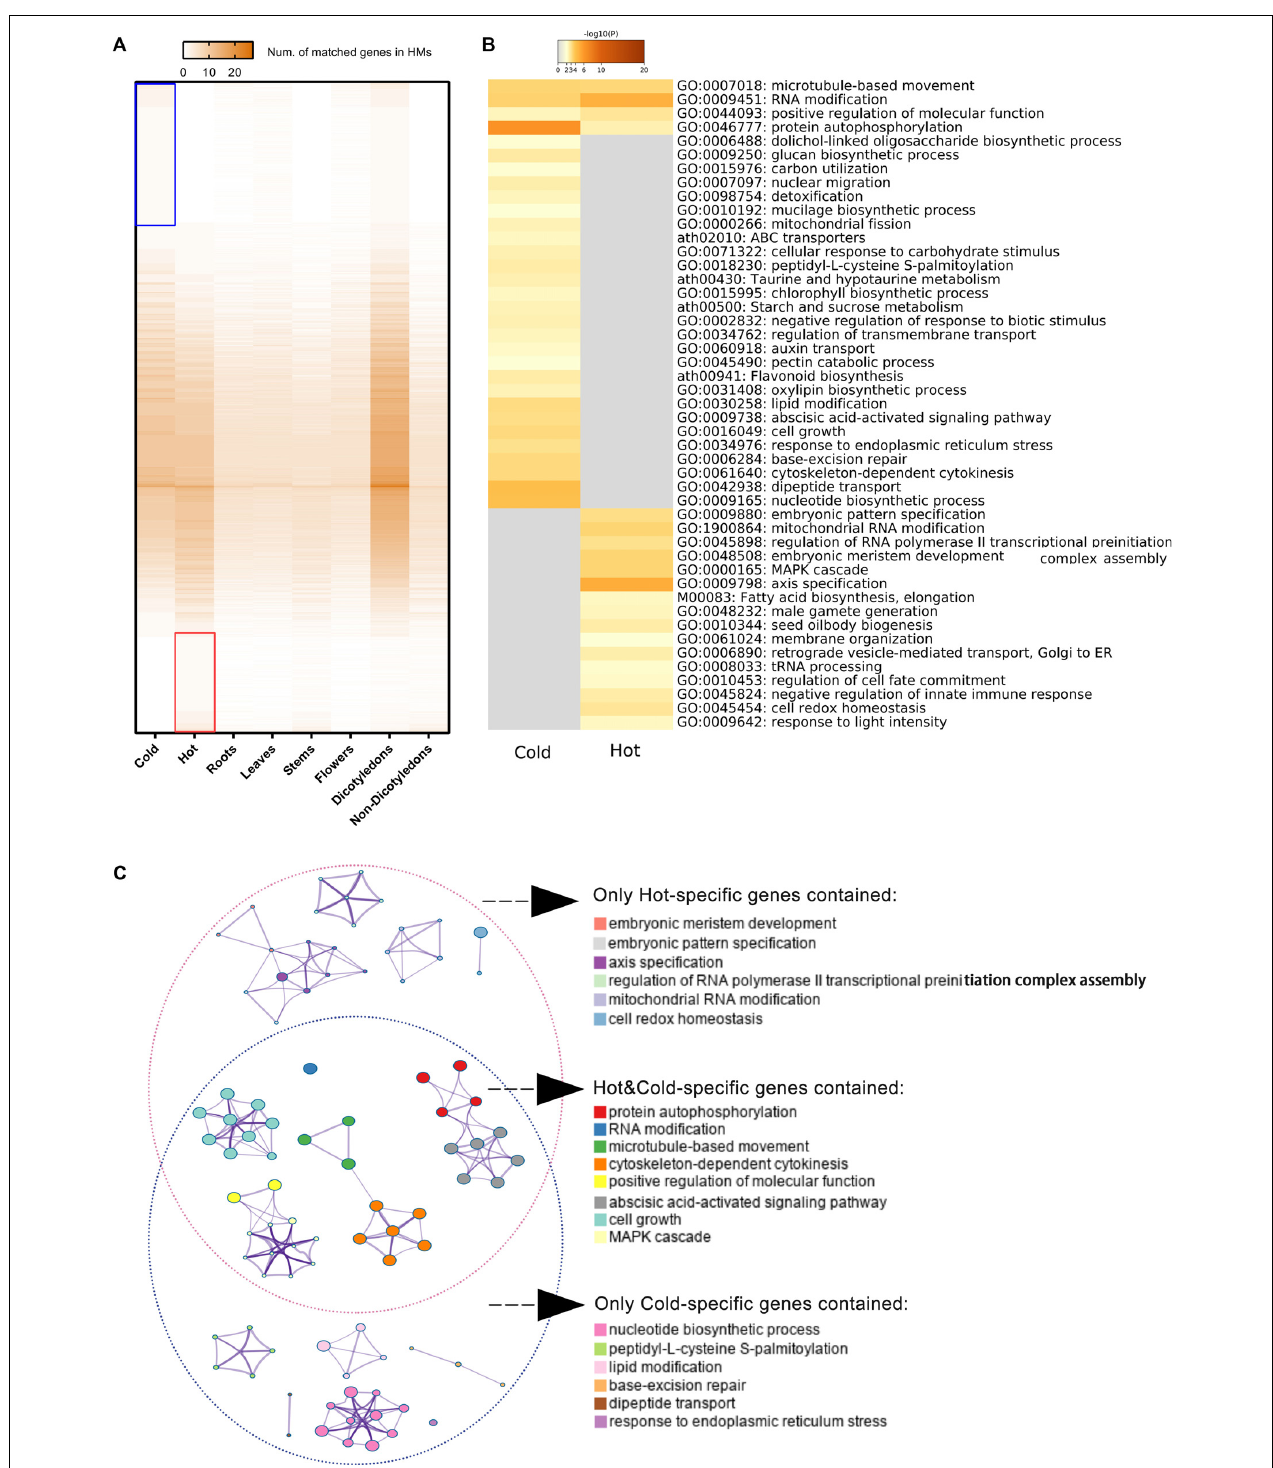
FIGURE 6 | Specific genes of cold/hot HMs and functional enrichment analyses results. (A) Heat map of numbers matched genes in different sample groups. The color key from gray to brown indicates small to large number of matches. Blue/red box indicates the reference genes matched only genes in the cold/hot group when genes divided into two groups according to their cold or hot HMs. (B) Heat maps of P -values of significant enriched functional categories on cold and/or hot group. The color key from gray to brown indicates large to small P -values. (C) Network of enriched categories basing on hot/cold-specific genes. Each node represents an enriched category. Its size indicated the number of genes, for which the category contained a range of 3–63. The thickness of the edge indicated the degree of membership similarity between two nodes. The representative terms of the clusters are shown on the legend.